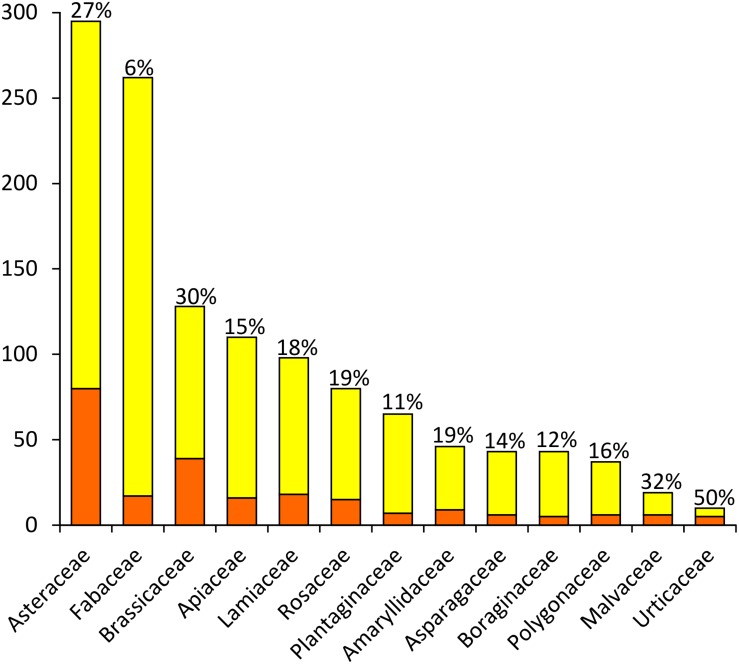
Plant families including more than 5 NWFP in Sicily. Orange: number of NWFP; Yellow: number of non-edible plants. The percentage of NWFP per family is reported on the top of each column.